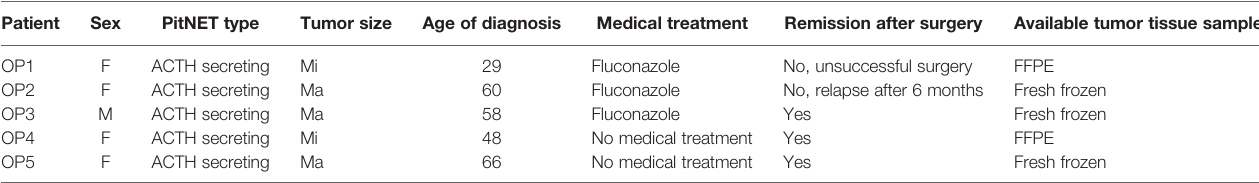
TABLE 1 | Group of patients with pre and postoperative plasma samples for evaluation by